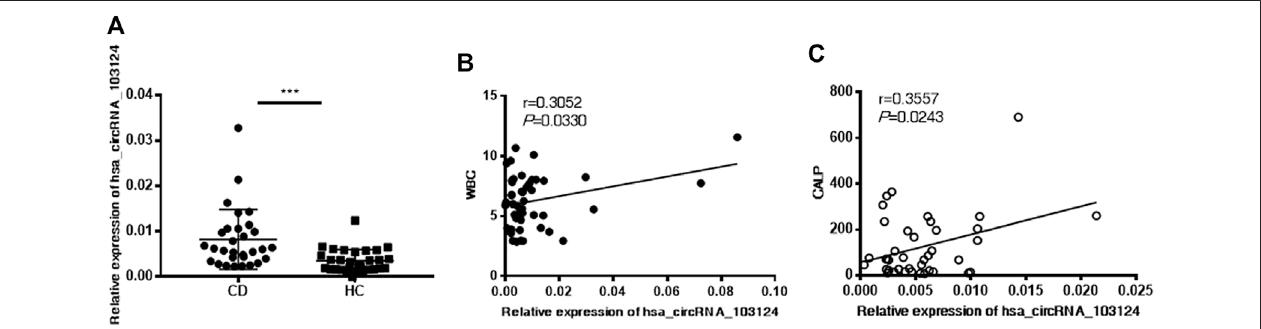
FIGURE 1 | Hsa_circRNA_103124 upregulation in patients with CD positively correlated with the WBC count and CALP level. (A) The relative expression level of hsa_circRNA_103124 in peripheral blood mononuclear cells from healthy controls (HC, n (cid:2) 40) or patients with CD ( n (cid:2) 60) was detected using RT-QPCR. (B,C) The correlation of hsa_circRNA_103124 expression with the WBC count (10 9 /L) or CALP level ( μ g/g) was analyzed by calculating Pearson ’ s correlation coef fi cients. *** p < 0.001.